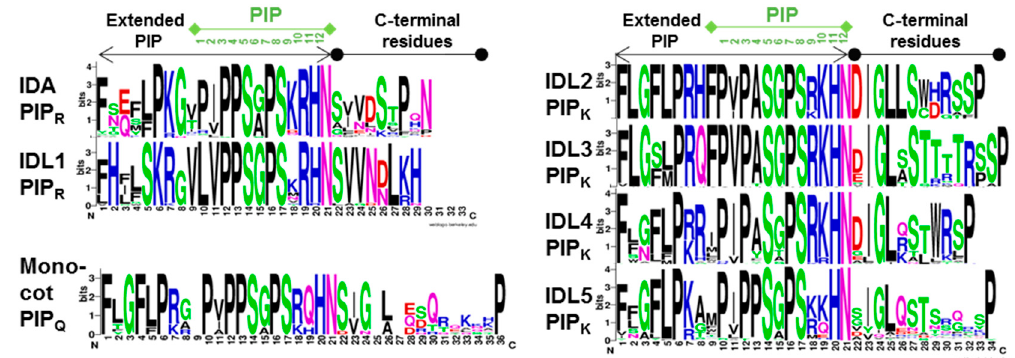
Figure 1. Conserved residues in propeptides of angiosperm IDA and IDL1-5 orthologues numbered from the start of the extended PIP motif to the C-terminal end. Sequences were aligned using Muscle, and consensus sequences were generated with logo@compbio.berkeley.edu. The PIP residues are